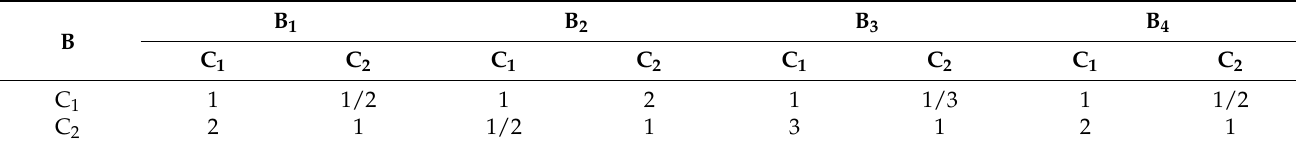
Table 5. Mutual factor weights of scheme layer c for rule layer B.